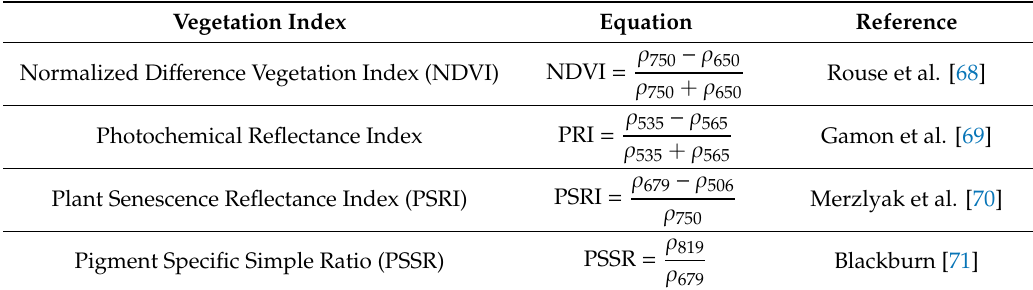
Table 4. Vegetation indices used in the study with their respective formulas and the references. Note: ρ is the reflectance at a specific wavelength in nm.